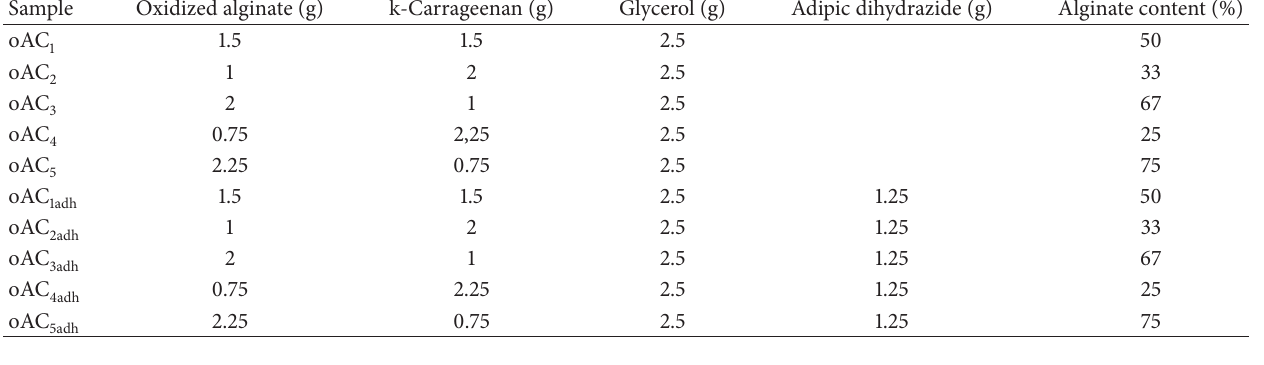
, oAC , oAC , oAC , and oAC ) and the covalently cross-linked films (oAC 1 2 3 4 5